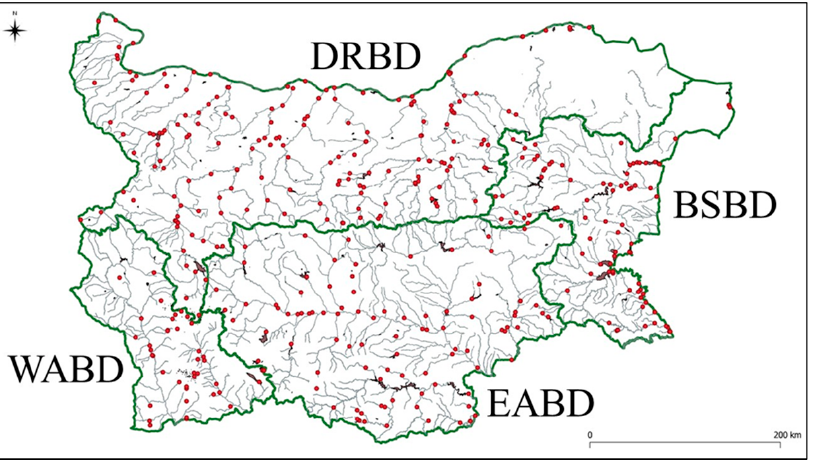
Figure 1. Sampling points for the determination of type-connected referent fish communities and biozonation in Bulgaria. (DRBD: Danube basin; BSBD: Black Sea basin; EABD: East Aegean basin; WABD: West Aegean basin).